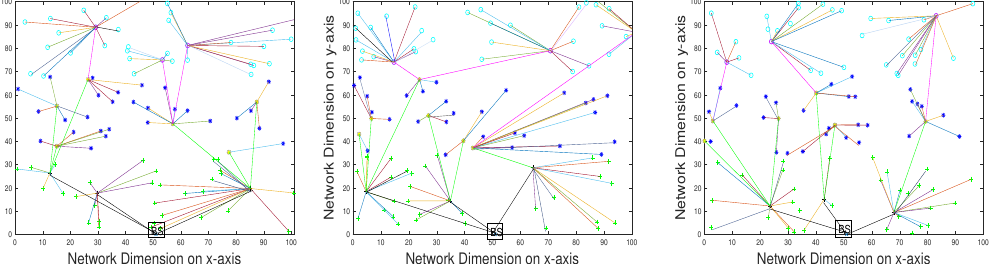
Figure 3. Multiple iterations of clustering topology in SADFIR.